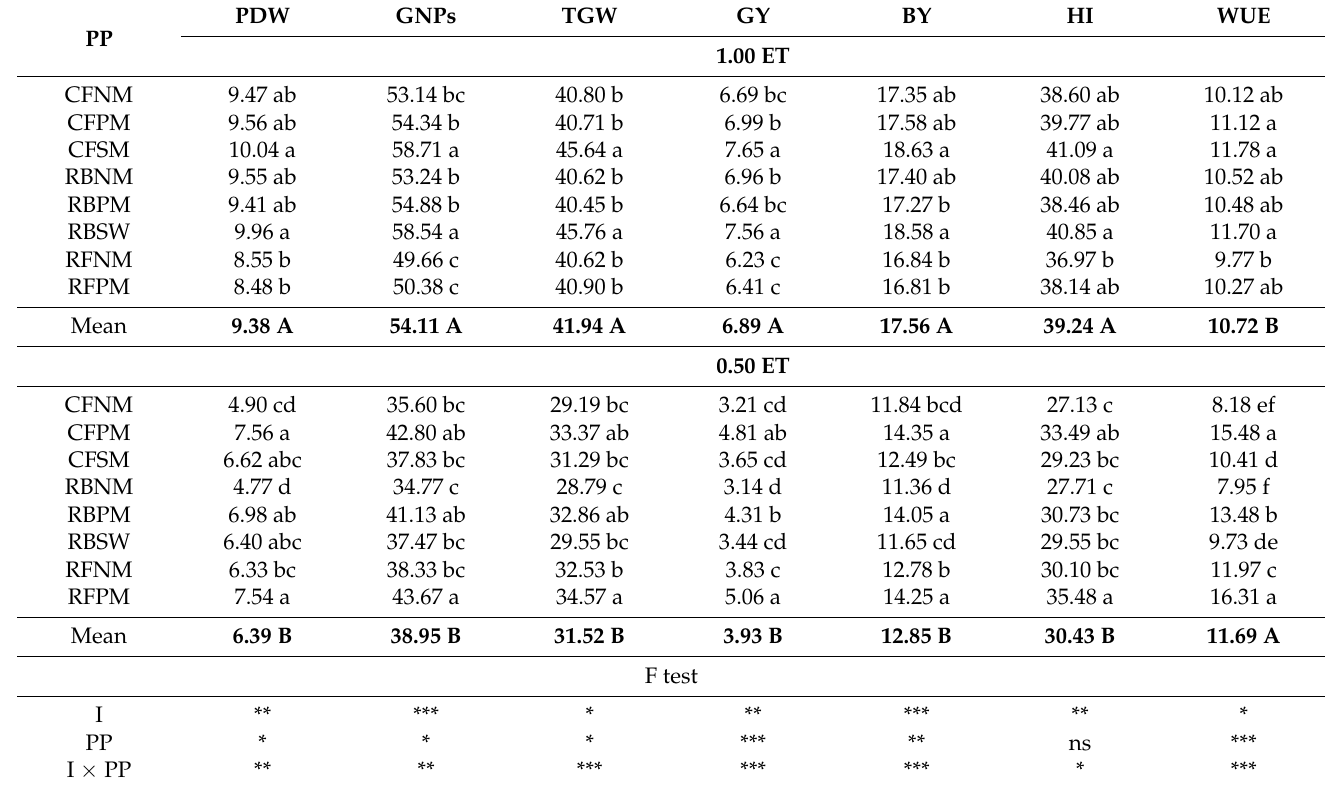
Table 1. Plant dry weight (PDW), grain number spike–1 (GNPS), 1000-grain weight (TGW), grain yield (GY), biological yield (BY), harvest index (HI), and water use efficiency (WUE), as affected by different combination of planting patterns (PP) and mulching under full (1.00 ET) and limited (0.50 ET) irrigation rate (I), and as main effects for the first